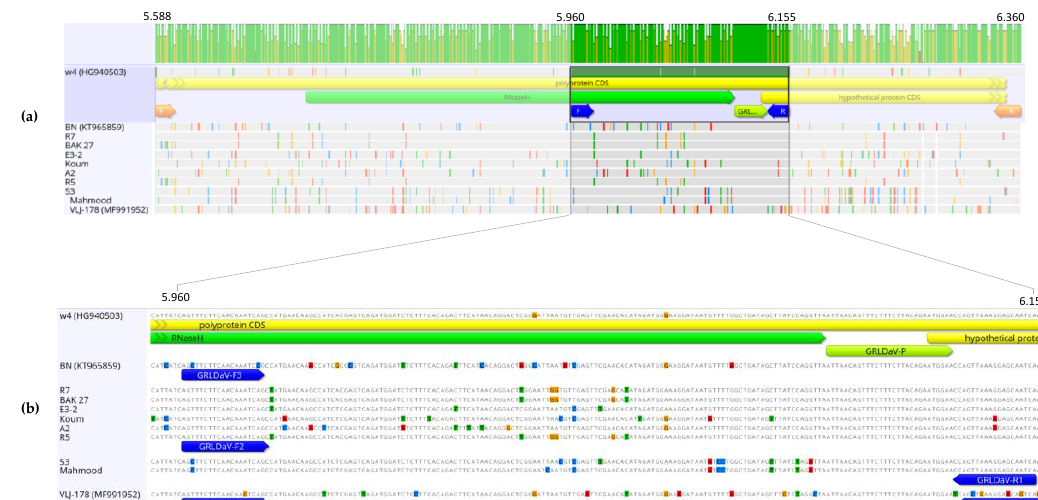
Figure 1. ( a ) Nucleotide alignment of 775 nt partial genomic sequences in the open reading frame 4 (ORF4) region (RNaseH) amplified from Grapevine Roditis leaf discoloration-associated virus (GRLDaV) isolates from different geographical origins. The corresponding region of three GRLDaV full-length sequences available in the databases is included. Alignment was performed by ClustalW implemented in MEGA X software. ( b ) One hundred and ninety-six nucleotide genomic target region, primers (blue arrows), and probe (green arrow) designed for the real-time qPCR developed in this study are indicated.